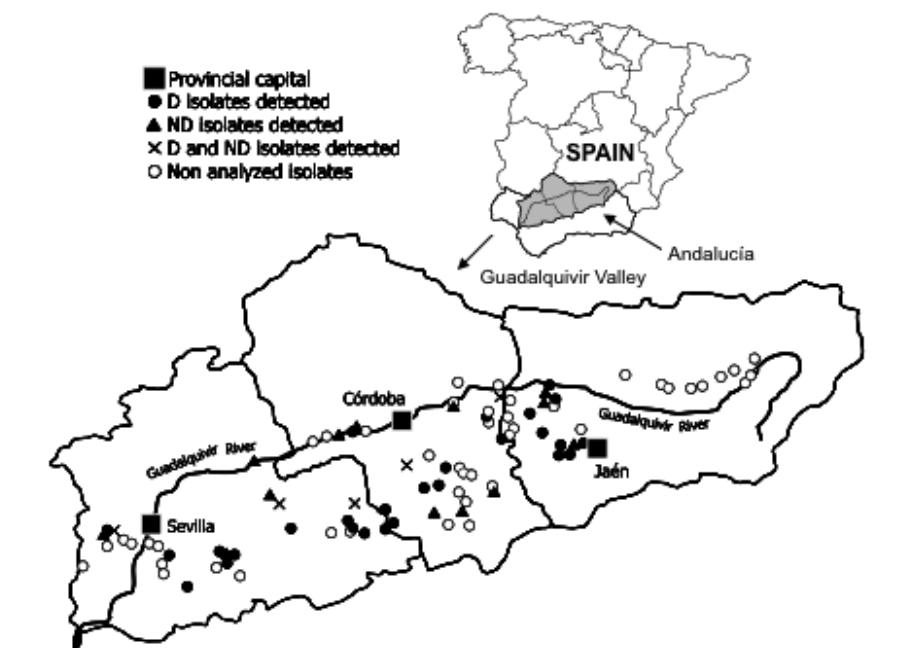
Figure 1. Distribution of Verticillium dahliae isolates in olive orchards surveyed throughout the Guadalquivir Valley (Southern Spain). D. Defoliating isolates; ND, non- defoliating